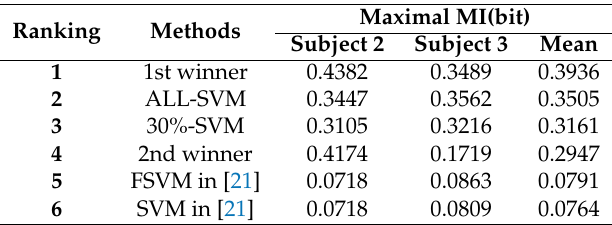
Table 4. Mutual information of the proposed combined feature vectors (100% and 30% of training data), methods in [21] and the winning methods of dataset II.